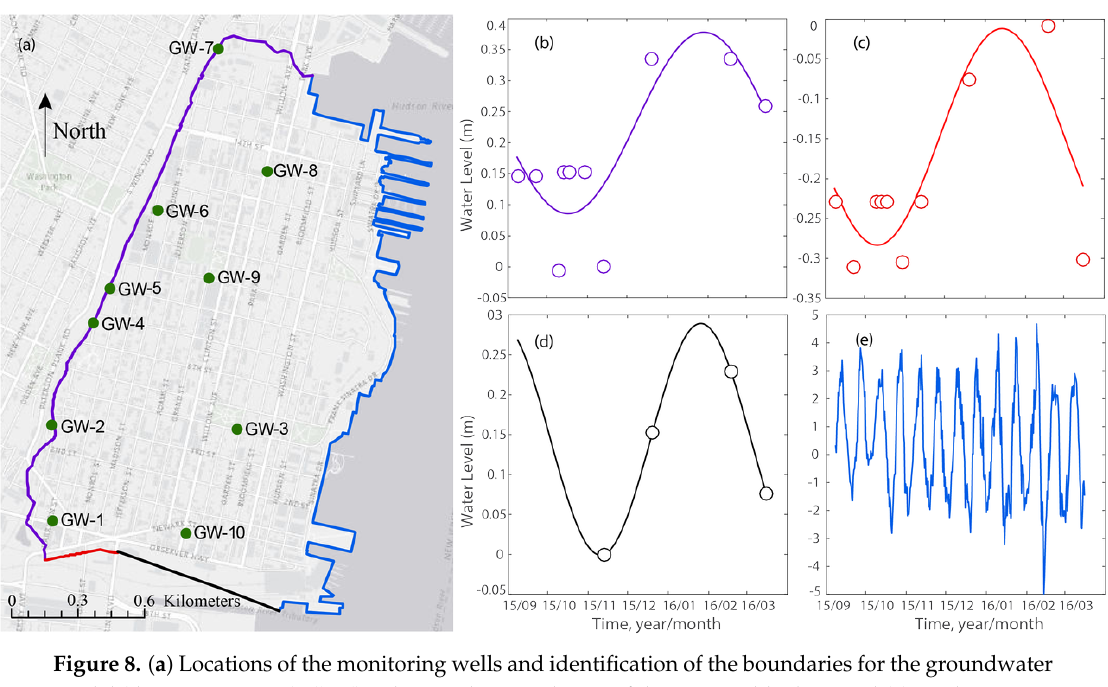
Figure 8. ( a ) Locations of the monitoring wells and identification of the boundaries for the groundwater model (datum NAVD 88); ( b – d ) values and interpolation of the water table data; and ( e ) Hudson River level at the Battery Park in New York City [68].